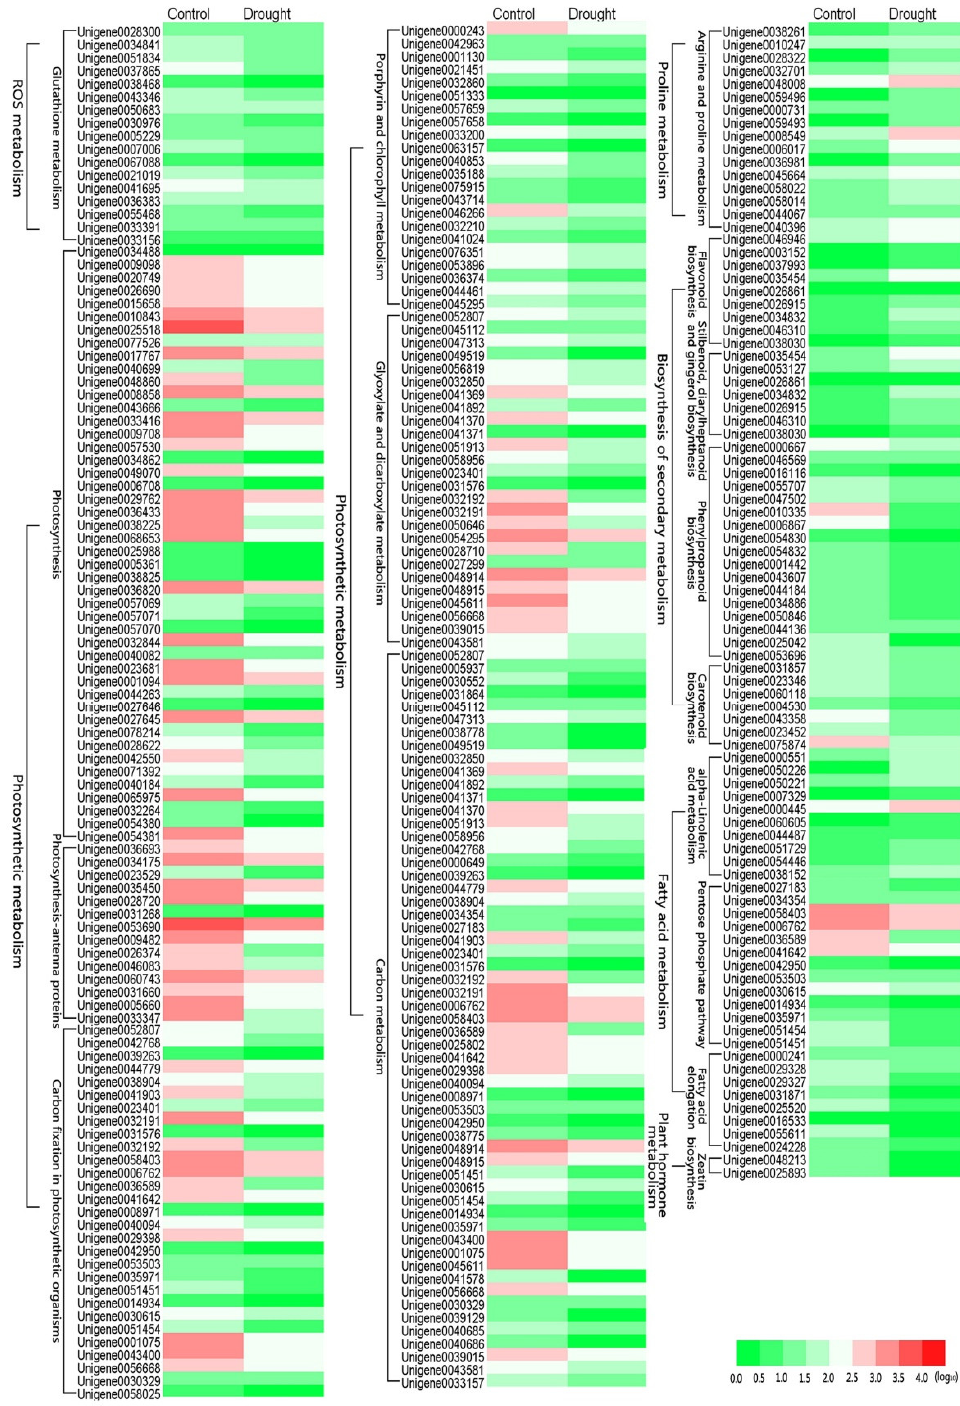
Figure 9. Heat map of main differentially expressed gene (DEG) expression patterns involved in reactive oxygen species (ROS) system, photosynthetic metabolism, proline metabolism, biosynthesis of secondary metabolism, fatty acid metabolism and plant hormone metabolism. Annotation information of DEGs can be found in Supplementary Table S3.